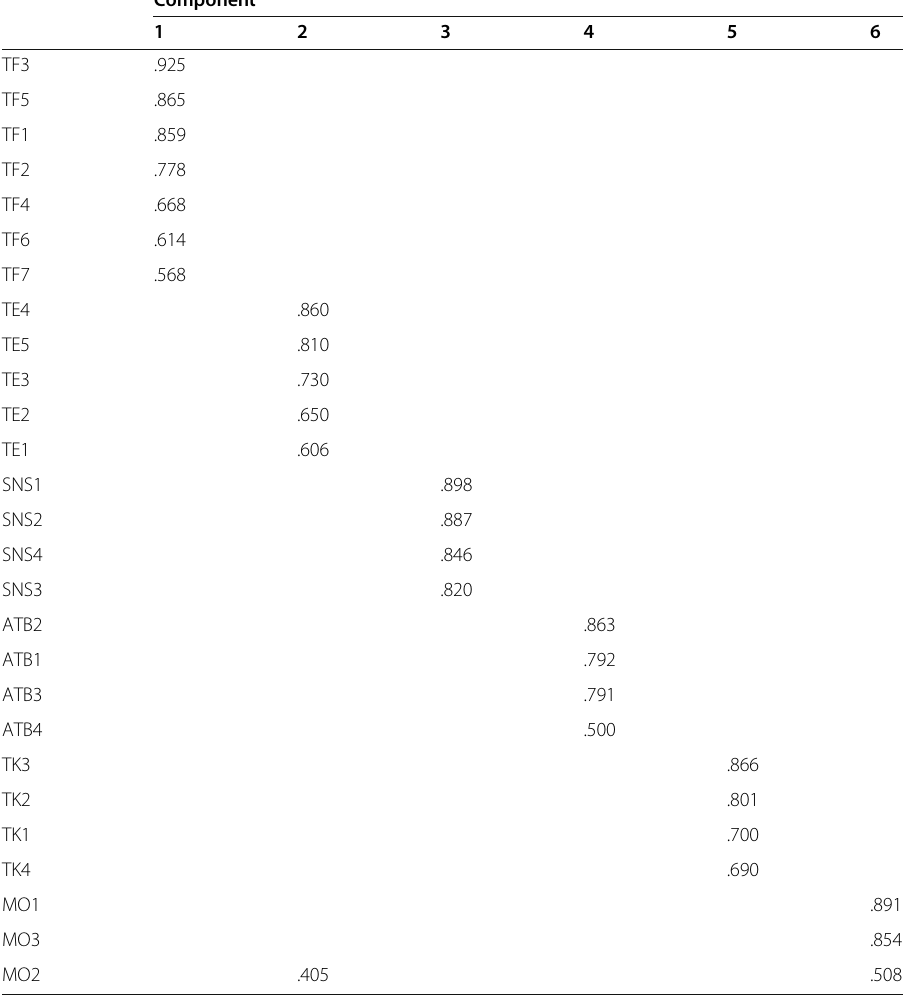
Table 4 Pattern matrix